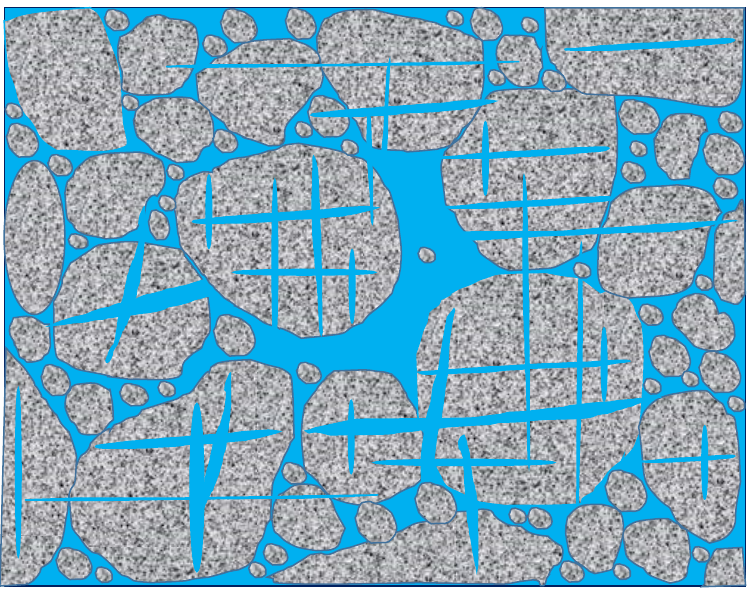
Figure 4. Scheme of tight sandstone pore structure with intergranular pores and microcrack network.